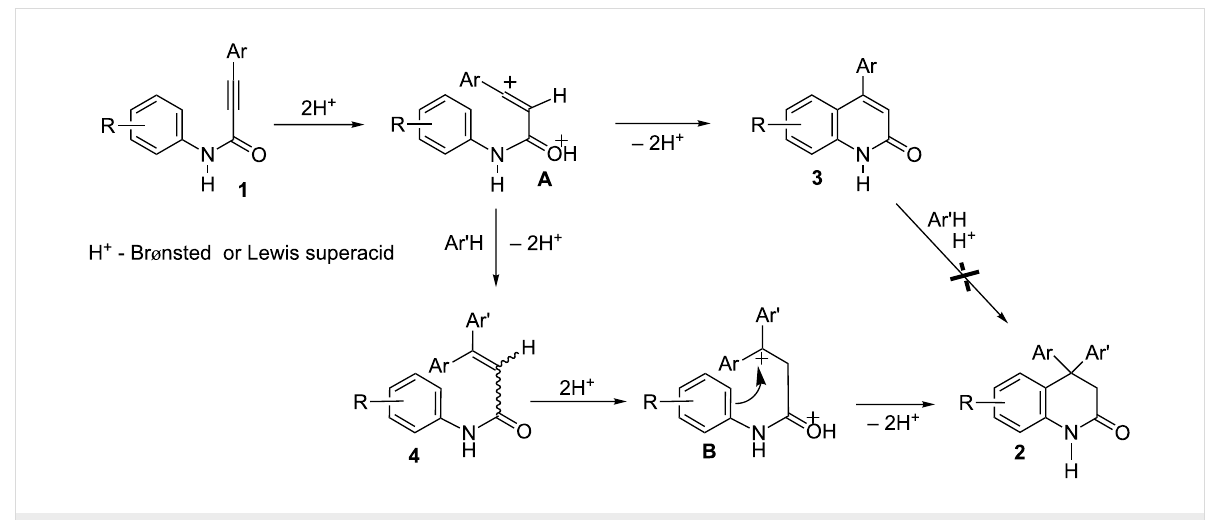
Scheme 1: Transformations of 3-aryl- N -(aryl)propiolamides 1 into 4-arylquinolin-2(1 H )-ones 3 or 4,4-diaryl-3,4-dihydroquinolin-2(1 H )-ones 2 in the presence of arenes through the formation of intermediate cations A , B under the superelectrophilic activation.